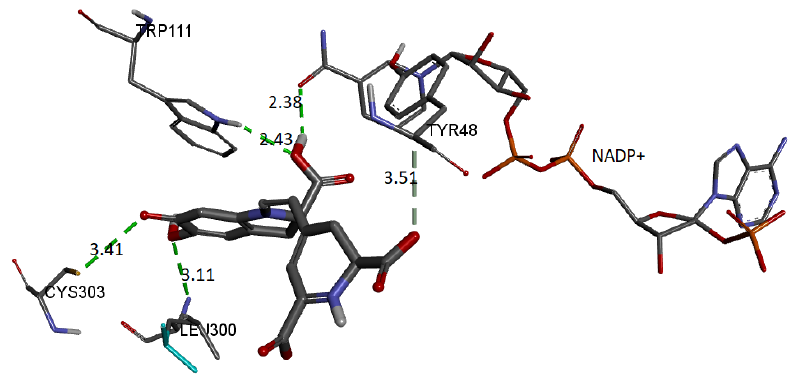
Figure 23. Molecular basis of potential active site interactions with deprotonated Bd Figure 23 Molecular basis of potential active site interactions with deprotonated Bd (C6C15C17- COOH).